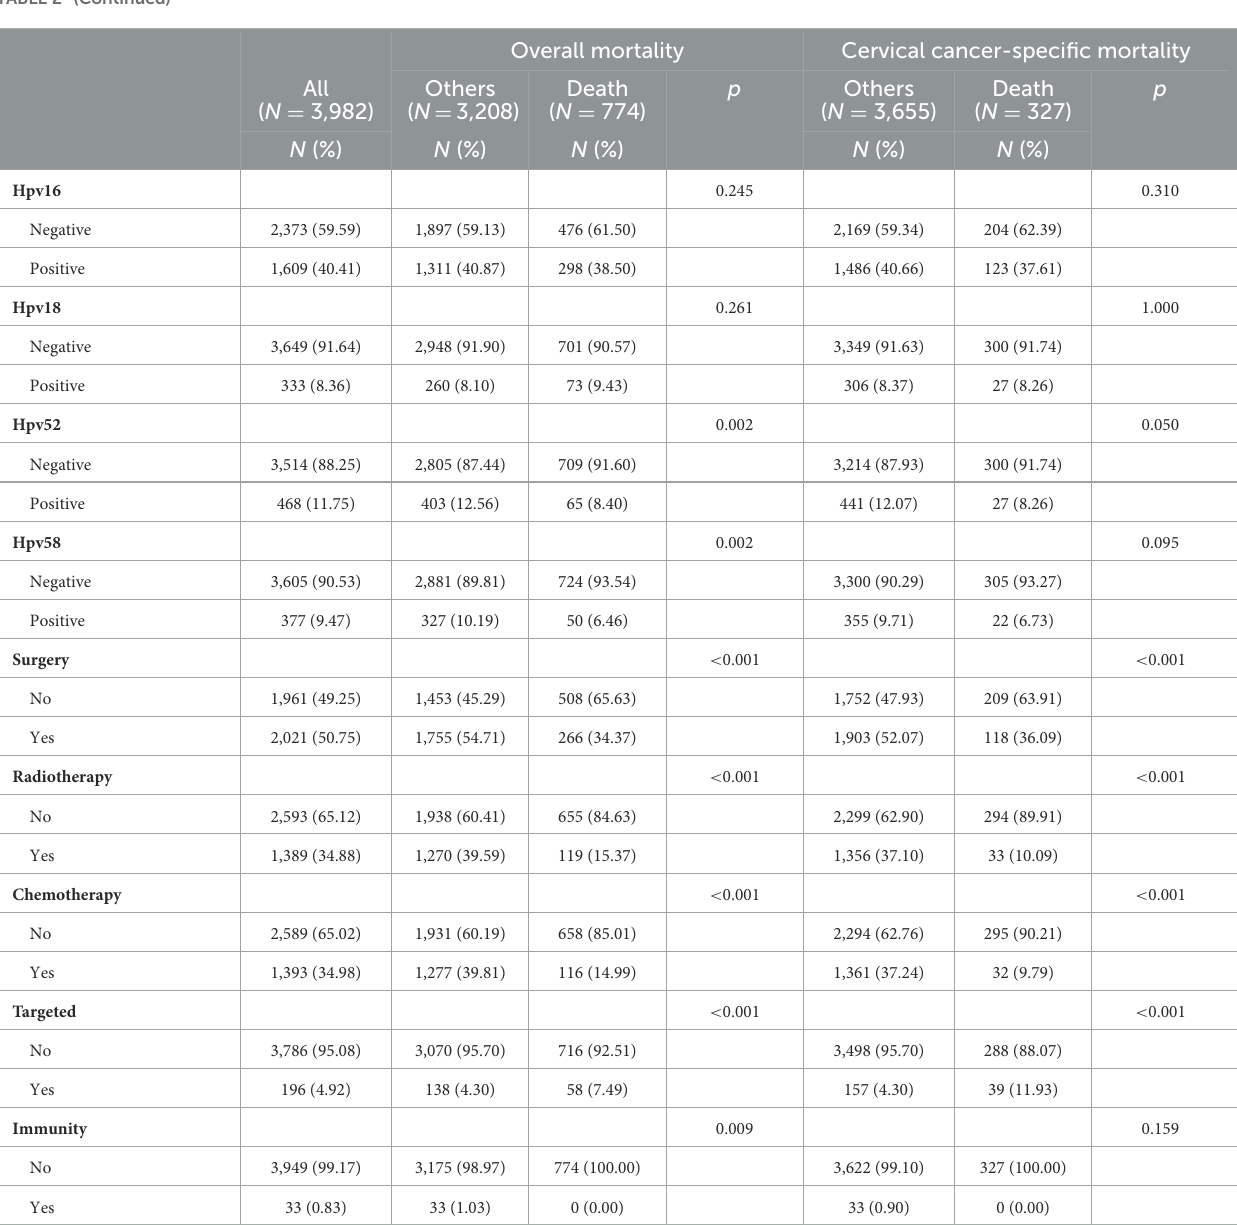
Table 2 shows the associations of demographic factors, the clinical characteristics, and treatment types with cervical cancer-specific mortality and all cause death. Among the included subjects, 774 patients with all-cause mortality, including 327 cervical cancer-specific deaths. Among the all-cause mortality group, there was difference in the age of diagnosis date, occupation, histopathological grading, stage, neutrophil granulocyte, lymphocyte, serum albumin, HPV52 infection status, HPV58 infection status, surgery, radiotherapy, chemotherapy and targeted were statistically significant ( p < 0.05). There was a statistically significant difference in the occupation, histopathological grading, stage, neutrophil granulocyte, lymphocyte, serum albumin, surgery, radiotherapy, chemotherapy and targeted in the cervical cancer-specific mortality group ( p < 0.05).